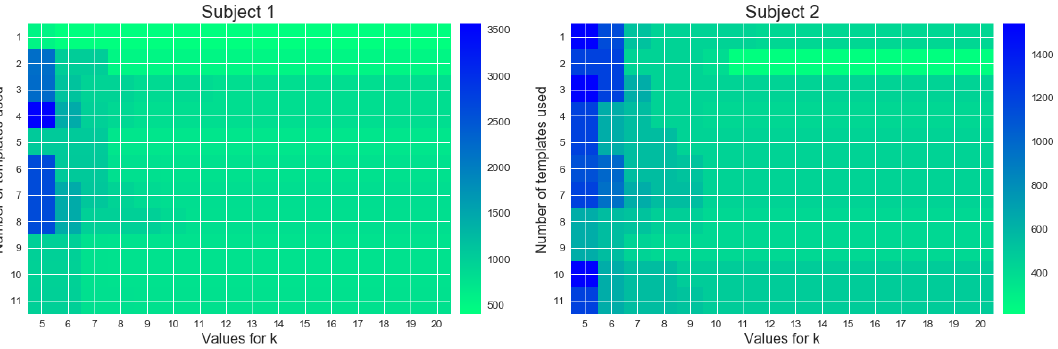
Figure 7. Results of matching activities of daily living with different numbers of templates used for matching and different values for k . The color shows the average distance (in ms) of a match to a